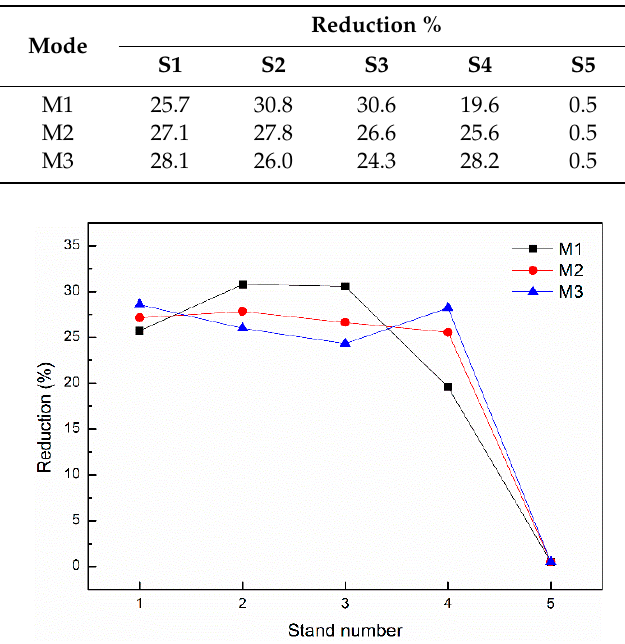
Figure 9. The reduction of each stand in M1, M2 and M3 for simulation.